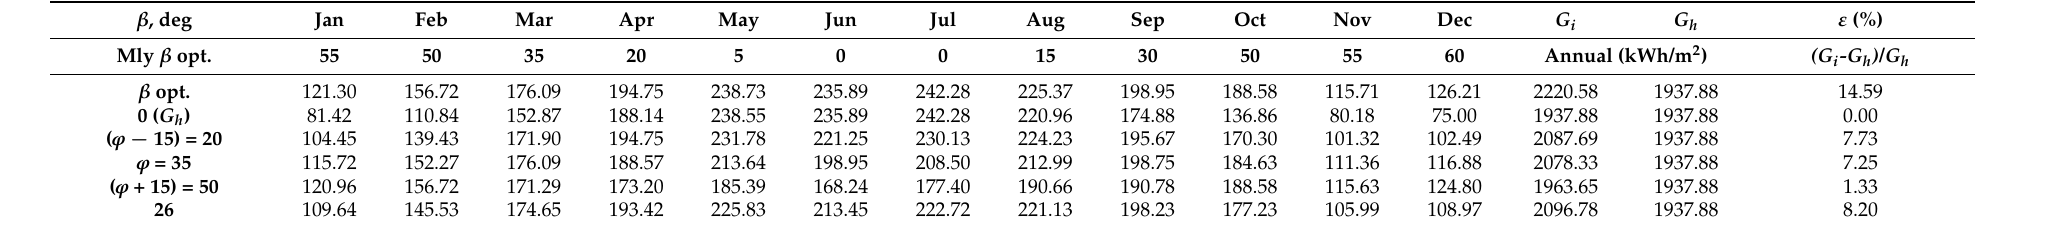
Table 17. Monthly total energy (kWh/m 2 /month) received by an inclined surface for each month of the year and for different slope angles ( β ). The percentage of the increase of annual energy with respect to horizontal is shown in the last column of the table. The first row represents the optimum slope for each month of the year, while β = 26 ◦ represents a permanent angle for the whole